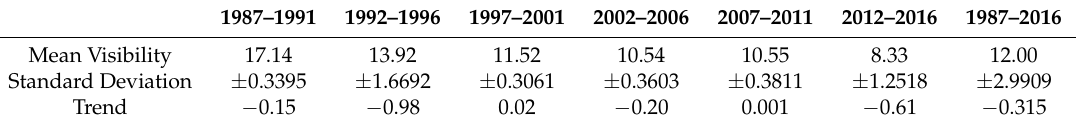
Table 2. Mean annual atmospheric visibility (km) of six periods and the change trends (km/year) of Xiamen, China.